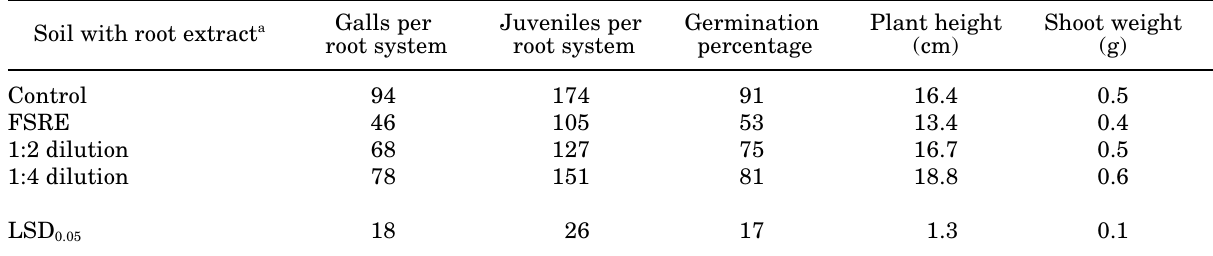
Table 2. Effect of root extract of Lantana camara at various concentrations on Meloidogyne javanica root-knot infection, nematode root populations and growth of mungbean.